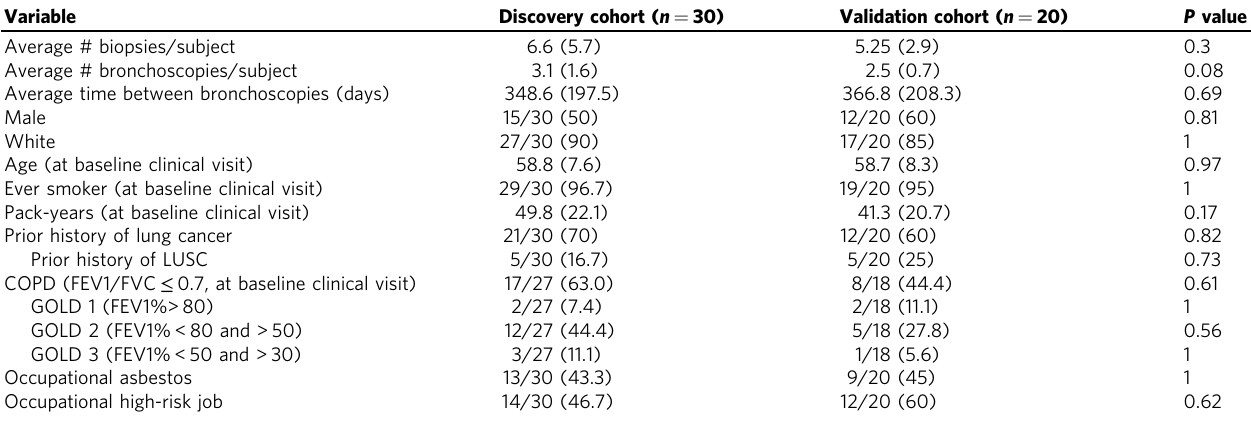
Table 1 Subject demographic and clinical annotation in the discovery and validation cohorts